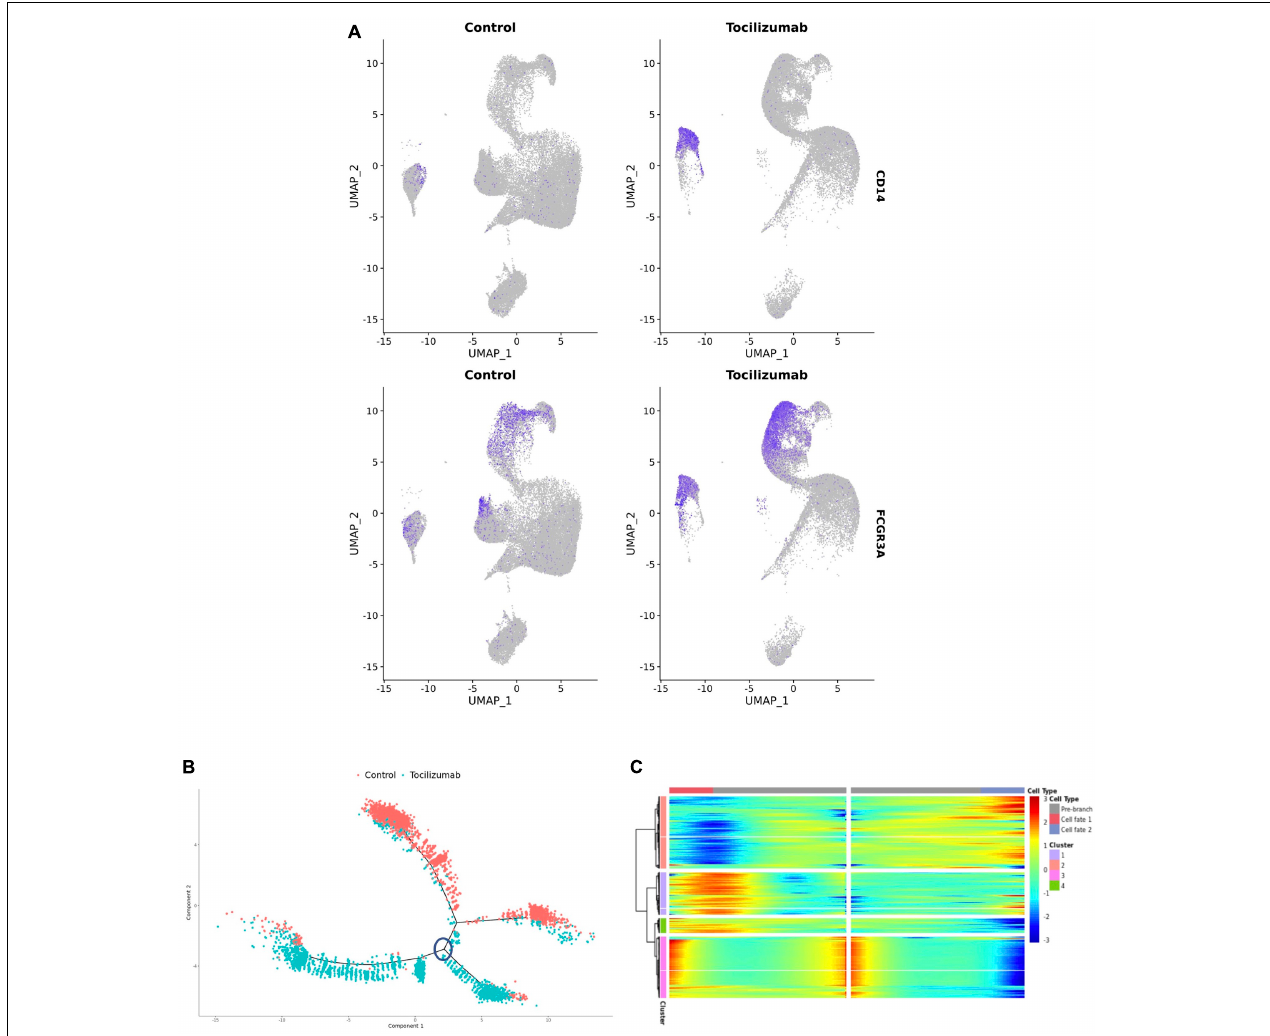
FIGURE 4 | Differential expression testing, cell trajectory analysis, and pathway analysis of monocyte subsets. (A) Feature plots showing expression of CD14 and CD16 based on control vs. Tocilizumab treatment status. Feature expression represented by color gradient, with high expression represented by blue and low expression represented by gray, with higher CD14 expression noted in Tocilizumab cells. (B) Cell trajectory analysis of monocyte clusters showing distinct lineages of control vs. Tocilizumab cells; blue circle represents branch point used in subsequent heatmap analysis. (C) Heatmap from branched expression analysis modeling for most differentially expressed genes between branch points from c (analyzed branch point marked by blue circle), showing clusters of differentially expressed genes between branches. Gene expression represented as color gradient from blue (low expression) to red (high expression). Cell type annotation represented by two separate cell fates as seen in (B) with middle of heatmap representing the start of pseudotime and clear separation of control vs. Tocilizumab cell